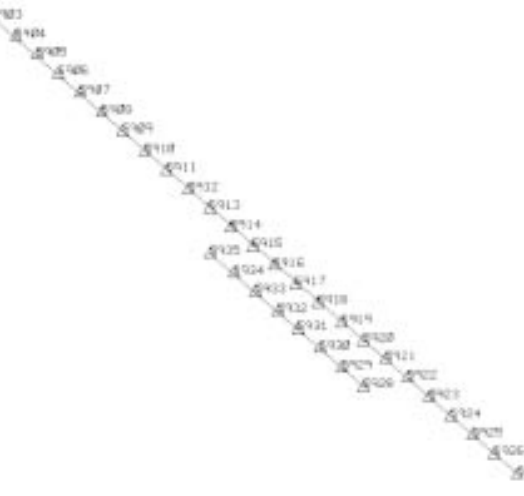
Fig 4. Corrected data